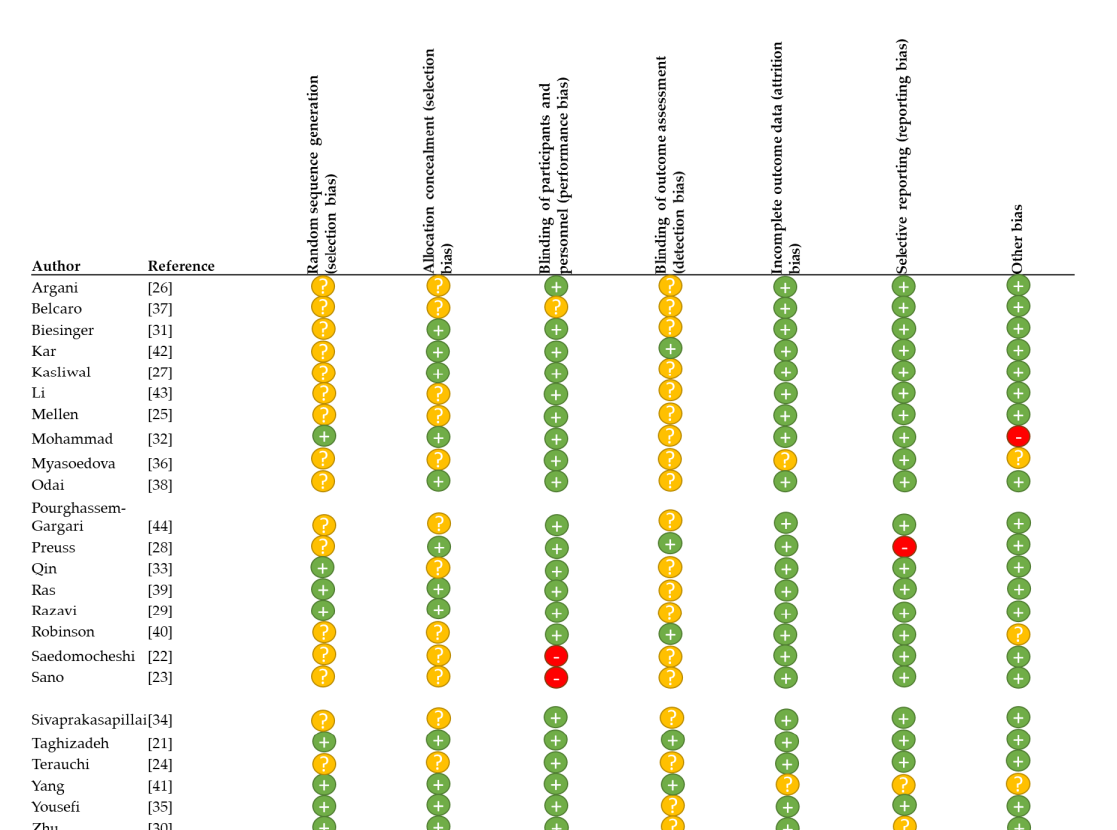
Nutrients 2021 , 13 , x FOR PEER REVIEW Figure 2. Cochrane evaluation of study bias; ”+” low risk of bias, “?” unclear risk of bias, “-“ high risk of bias.